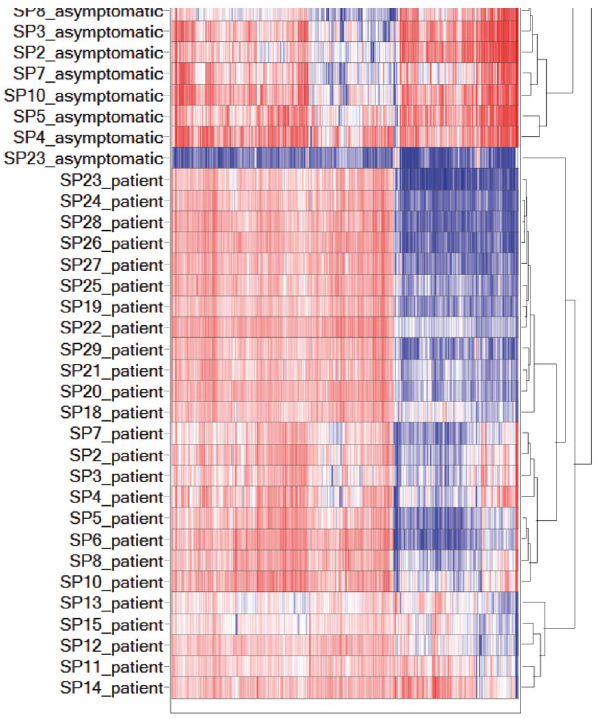
Figure 2. Supervised hierarchical correlation clustering of 27 sample pairs. The heat map shows the gene expression of samples in columns, with a dendogram representing their similarity based on correlation. The samples’ mean-subtracted log2 signal values were clustered using complete linkage (maximum) method and the genes’ expression is shown with blue representing down-regulation, white for no change (zero), and red for up-regulation.